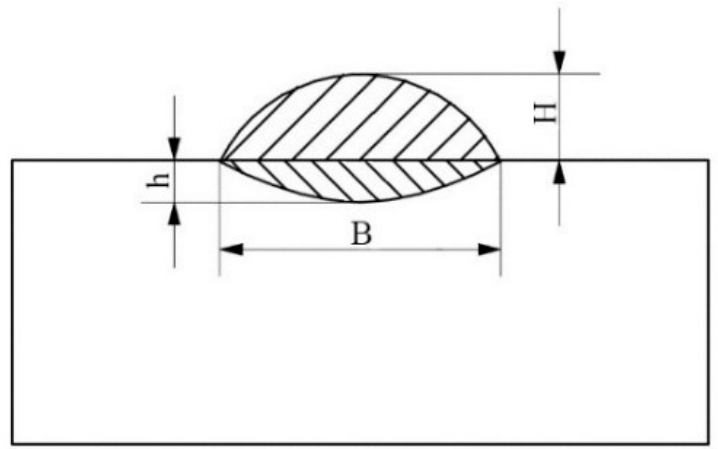
Figure 10. The measured depth of fusion H = 0.79 mm, width of fusion B = 10.08 mm and reinforcement H = 2.24 mm. Due to the large size of the surfacing model, in order to improve the calculation efficiency and accuracy, the grid form of alternate density is adopted, that is, the welding part adopts a denser grid, and the part far away from the weld adopts a thicker grid. The size of the substrate is the same as that of the base metal; use visual mesh module finite element model.